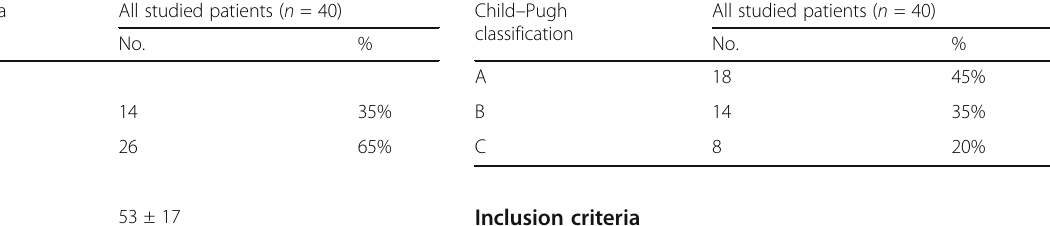
Table 3 Child – Pugh classification of all studied patients Child – Pugh classification